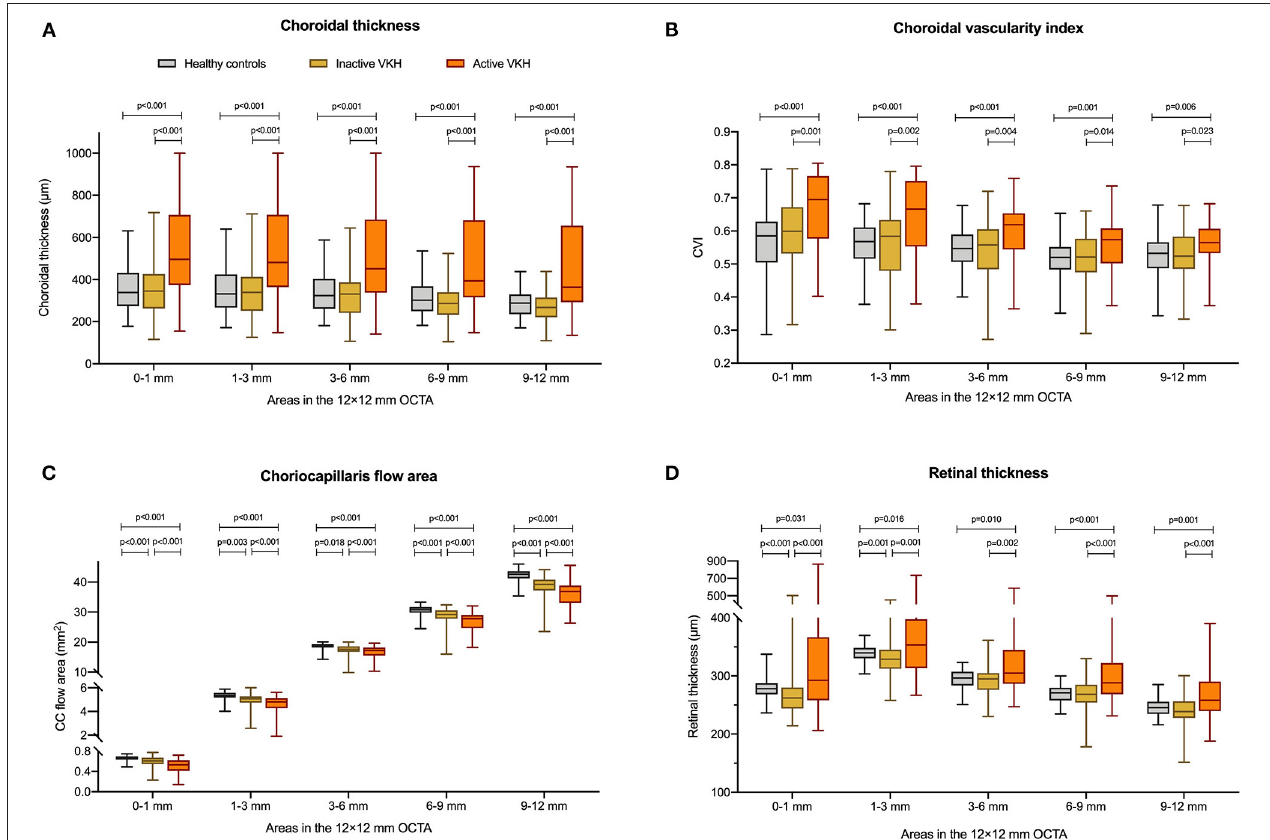
FIGURE 1 | Comparisons of (A) choroidal thickness, (B) choroidal vascularity index (CVI), (C) choriocapillaris (CC) flow area, and (D) retinal thickness between healthy controls, inactive Vogt-Koyanagi-Harada (VKH), and active VKH patients in the central fovea (0–1mm) and different radius of concentric rings (1–3, 3–6, 6–9, 9–12mm) on the 12mm × 12mm swept-source optical coherence tomography angiography (SS-OCTA) scans. Data are shown in composite box plots. Whisker: minimum to maximum; box: interquartile range; lower and upper borders of box: the lower and upper quartiles (25th and 75th percentiles); line inside the box: